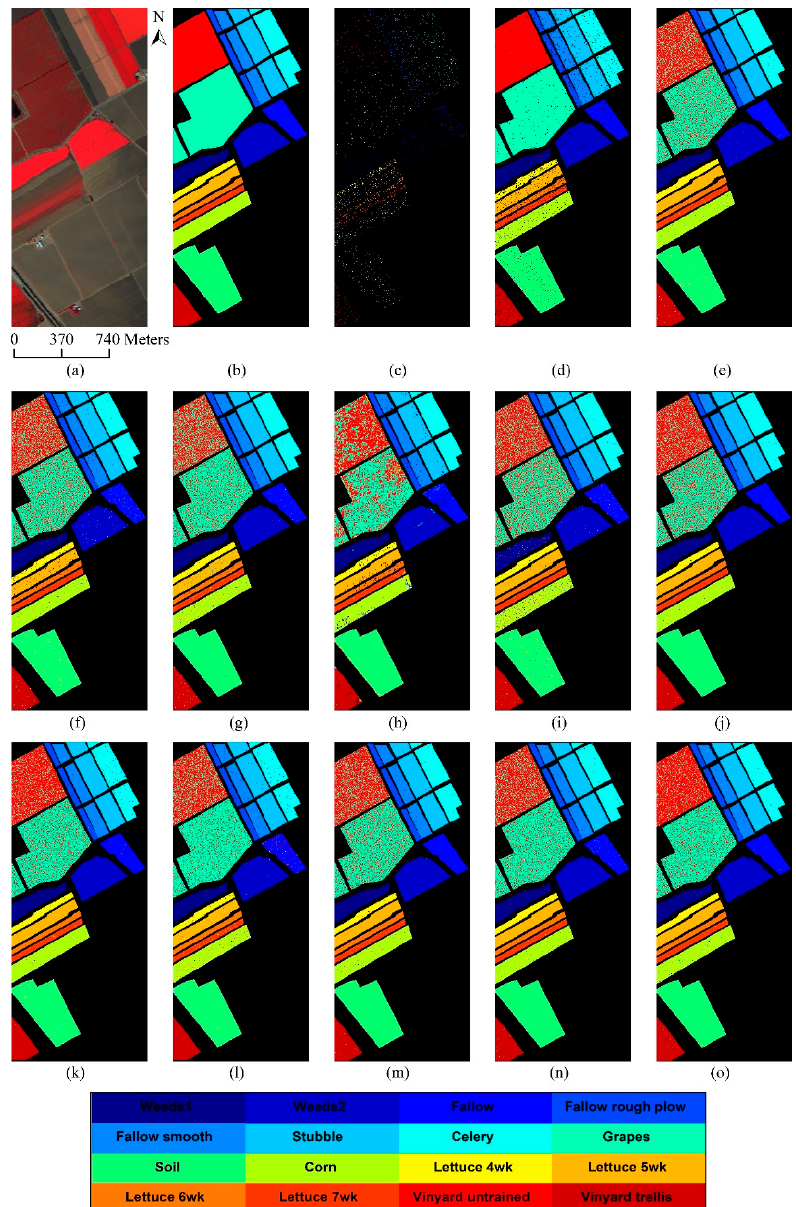
Figure 7. Classification maps generated with 120 training samples per class on the Salinas image.